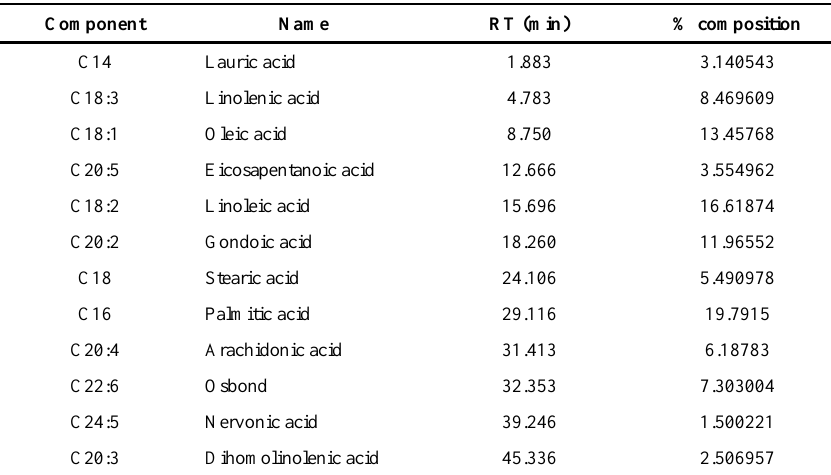
Table 2. Summary of the fatty acid profile of the produced